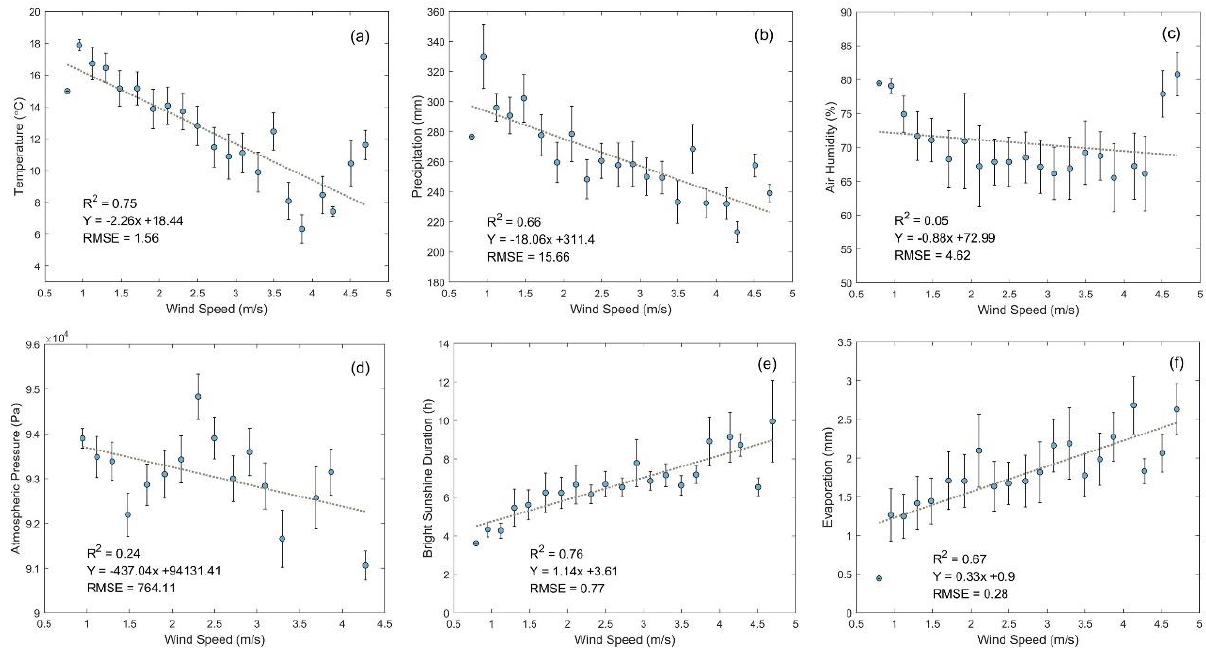
Figure 7. Correlation analysis results and error bars between wind speed and ( a ) temperature; ( b ) precipitation; ( c ) air humidity; ( d ) atmospheric pressure; ( e ) bright sunshine duration; ( f ) evaporation.